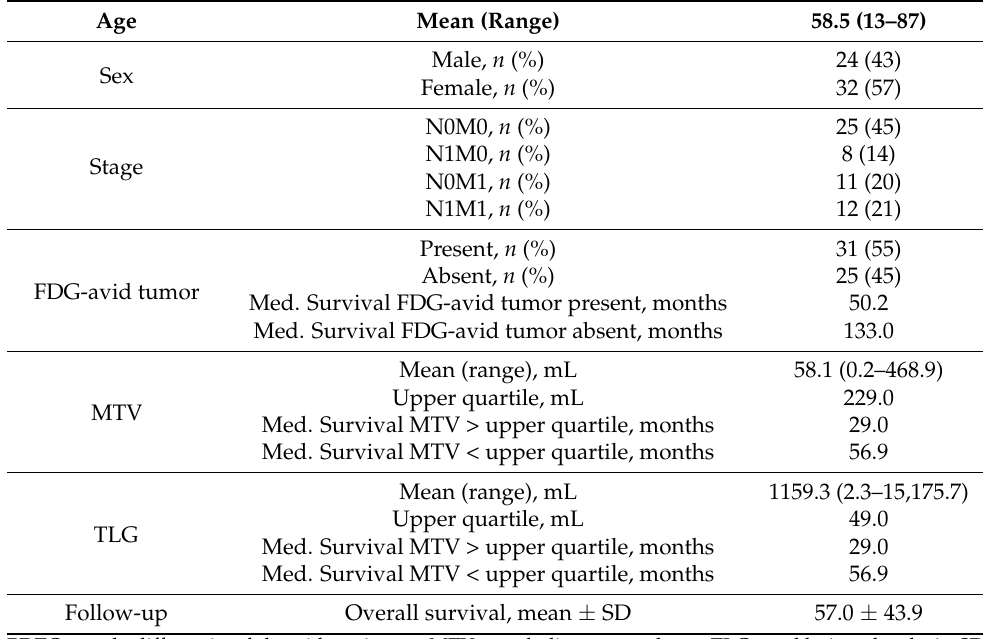
Table 2. Patient characteristics for the assessment of positron-emission tomography (PET) parameters as prognostic factors for overall survival.